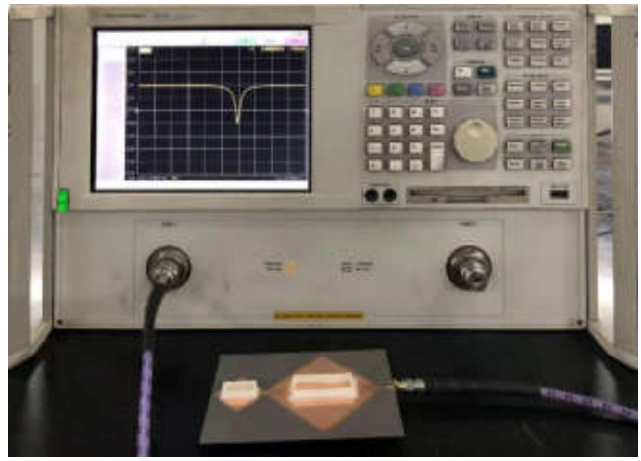
Figure 5. The measurement